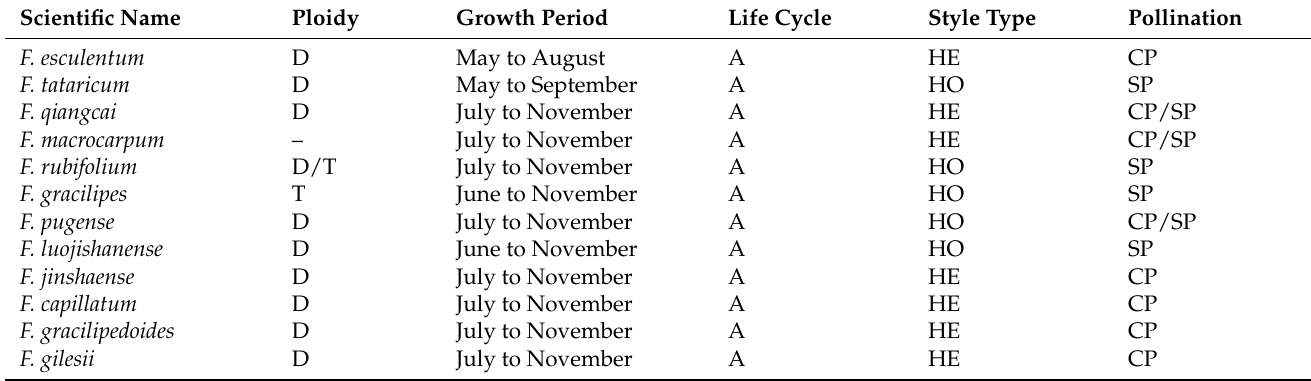
Figure 1. The morphological characteristics and distribution of wild buckwheat species. ( A ) represents the plant morphology and biotope of nineteen wild and two cultivated species: ( a ) F. tataricum , ( b ) F. esculentum , ( c ) F. cymosum , ( d ) F. statice , ( e ) F. jinshaense , ( f ) F. qiangcai , ( g ) F. pugense , ( h ) F. urophyllum , ( i ) F. caudatum , ( j ) F. gracilipedoides , ( k ) F. lineare , ( l ) F. leptopodum , ( m ) F. gilesii , ( n ) F. capillatum , ( o ) F. macrocarpum , ( p ) F. hailuogouense , ( q ) F. gracilipes , ( r ) F. luojishanense , ( s ) F. rubrifolium , ( t ) F. homotropicum , and ( u ) F. crispatofolium . ( B ) represents the distribution of wild buckwheat species in China. Table 2. The biological characteristics of wild